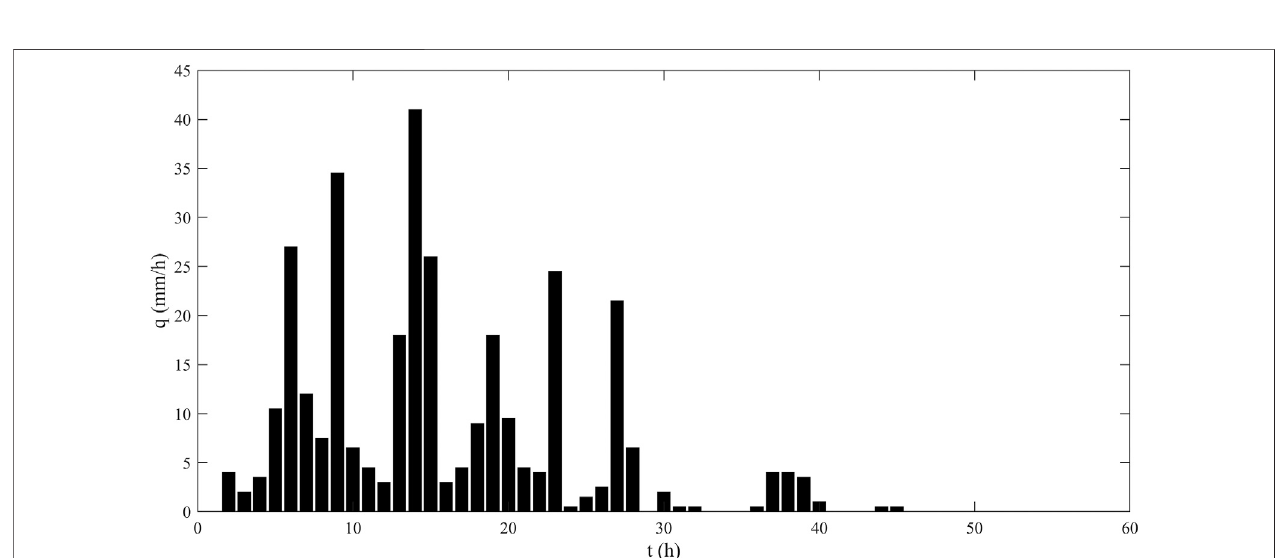
FIGURE 3 | Rainfall intensity at the Chen ’ ao Reservoir during the Typhoon